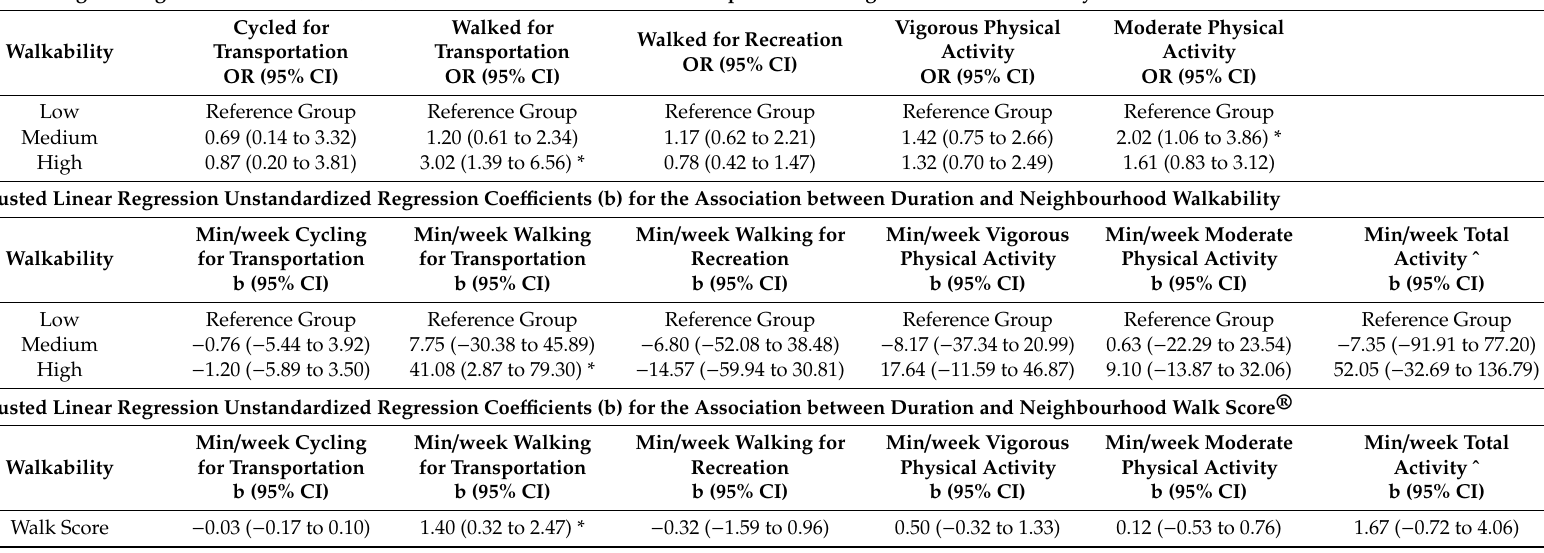
Table 5. Associations between self-reported participation in and duration of perceived neighbourhood-based physical activity and Walk Score ® measured neighbourhood walkability at Time 1 only ( n =